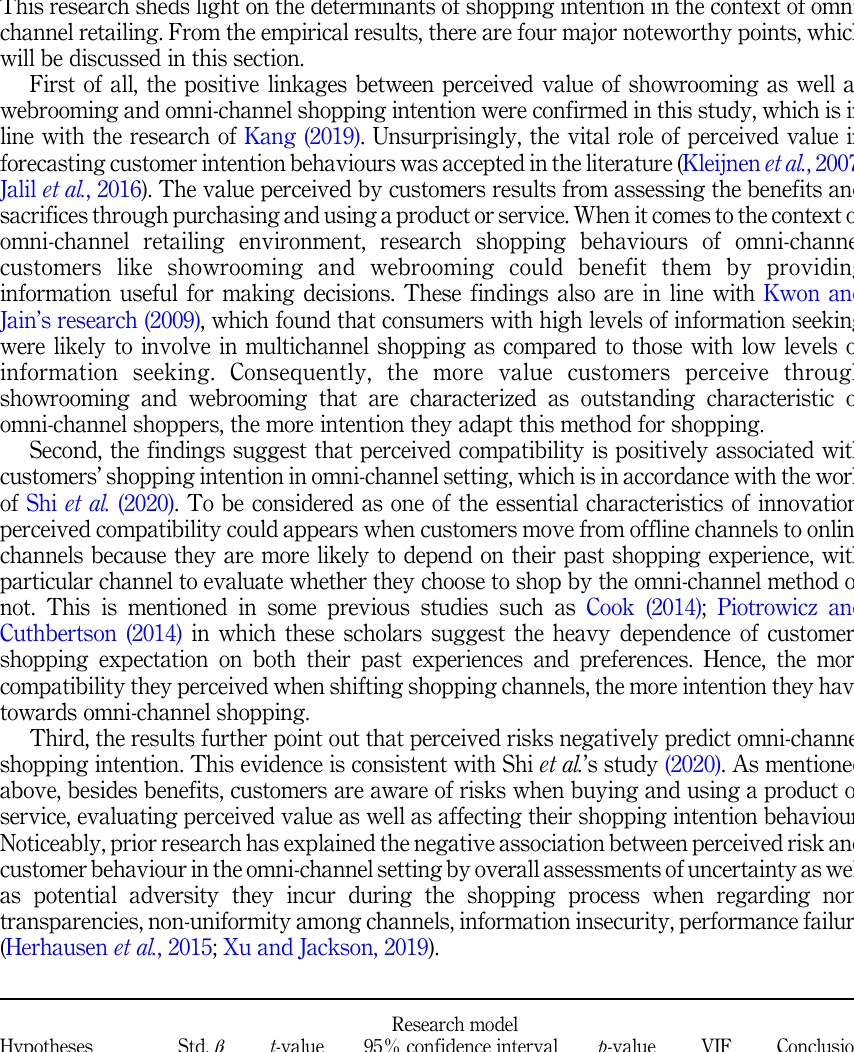
Table 4. The results of testing research